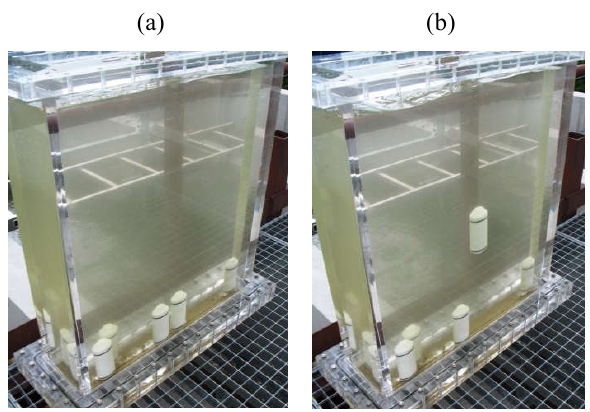
Figure 6. Sensor particles during the automated taring regime in a fluid sample: (a) residence at the container bottom and (b) elevated position during the automated taring